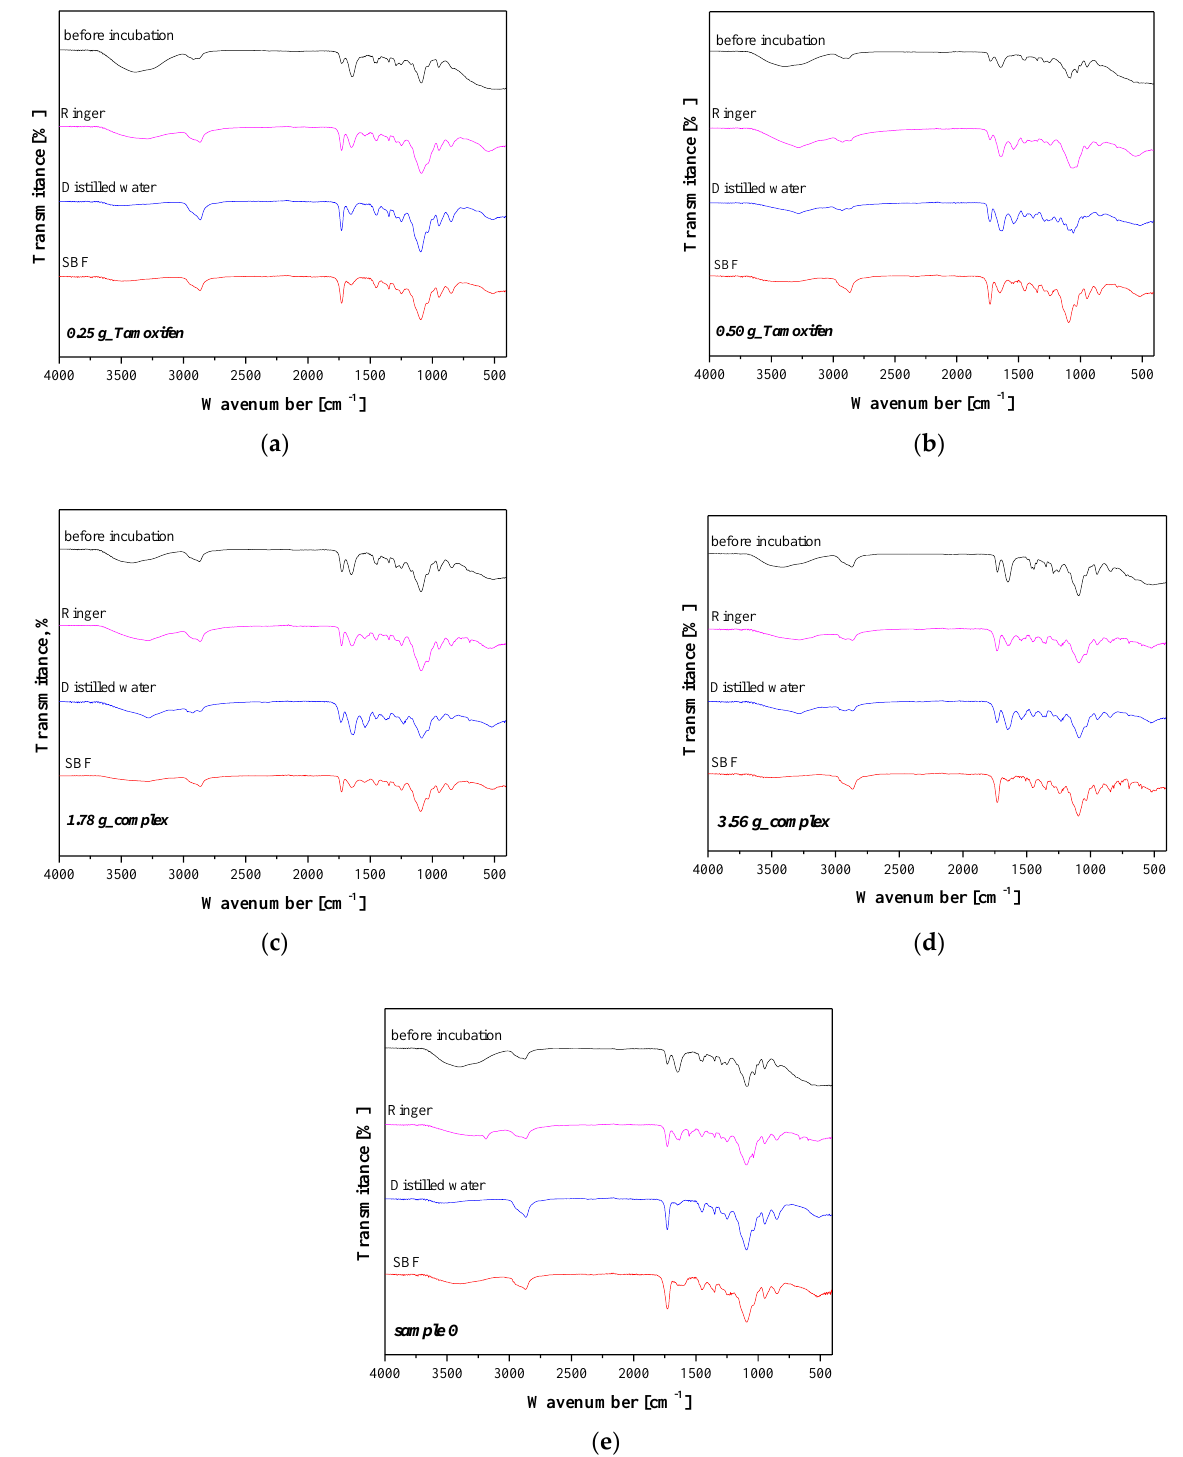
Figure 9. FT-IR spectra of hydrogel samples: 0.25 g_Tamoxifen ( a ), 0.50 g_Tamoxifen ( b ), 1.78 g_complex ( c ) and 1.78 g_complex ( d ) and 3.56 g_complex ( e ) 0.0 g_Tamoxifen. Additionally, below, in Table 5, weights of the samples measured during the two-week incubation in simulated physiological liquids are shown.